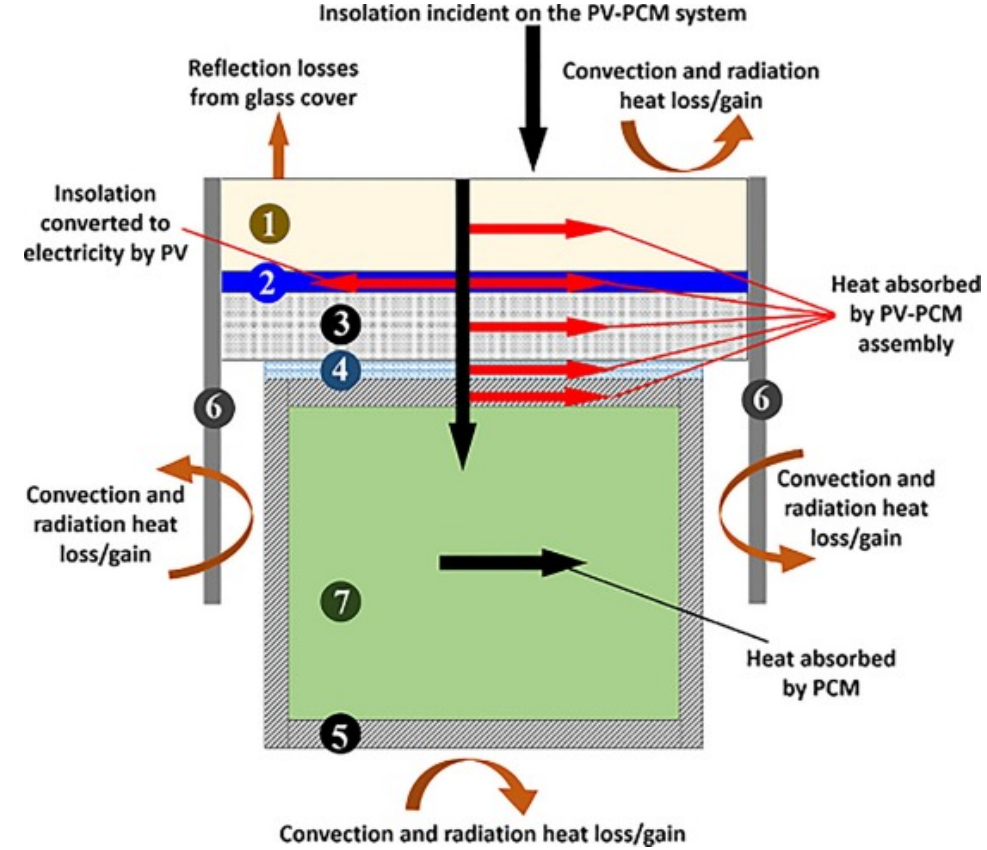
Figure 51. Schematic of a PV-PCM system: (1) glass cover; (2) cell of the PV panel; (3) back sheet of the PV panel; (4) epoxy glue layer; (5) wall of the PCM container; (6) frame of the PV panel; and (7) layer of PCM [196].